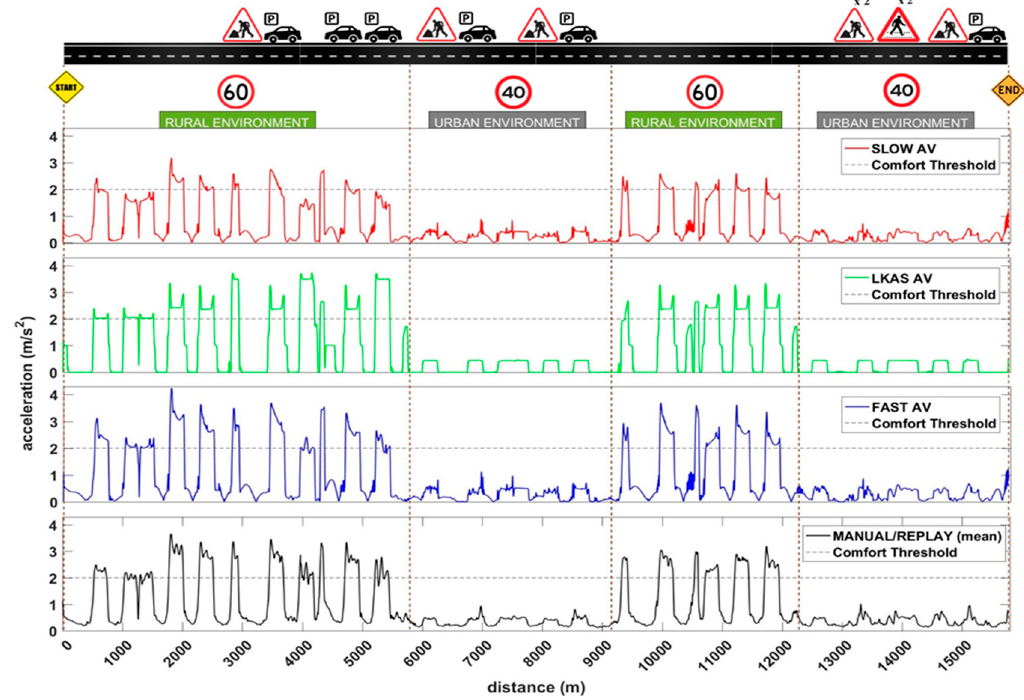
Figure 2. Resultant acceleration of the different controllers and manual driving, along with the location of obstacles across all drives, except LKAS.